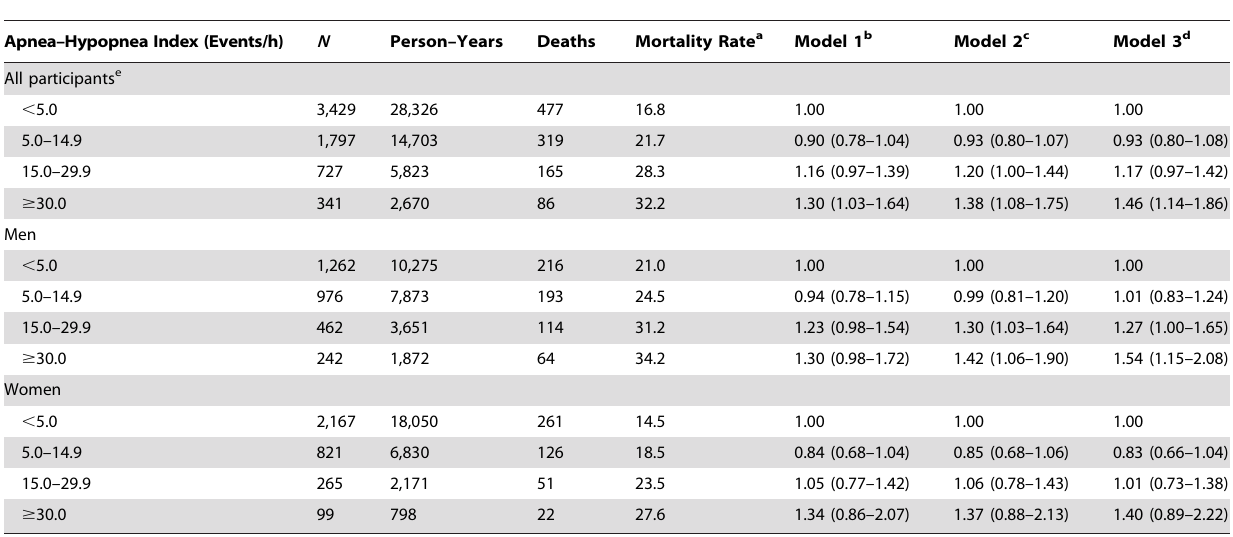
Table 2. Adjusted hazard ratios (95% confidence intervals) for all-cause mortality associated with sleep-disordered breathing in the Sleep Heart Health Study.